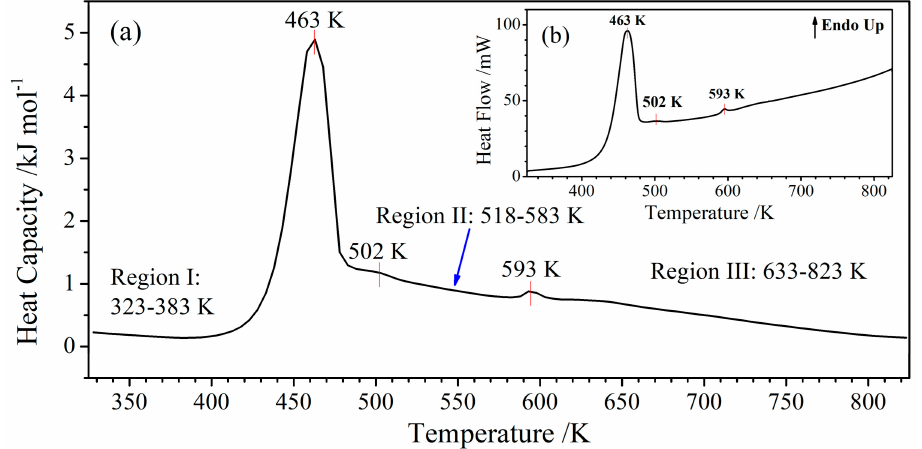
Figure 4. DSC result: ( a ) heat capacity curve of MgHPO 4 · 3H 2 O and ( b ) heat flow curve. Region I; T 1 = 323–383